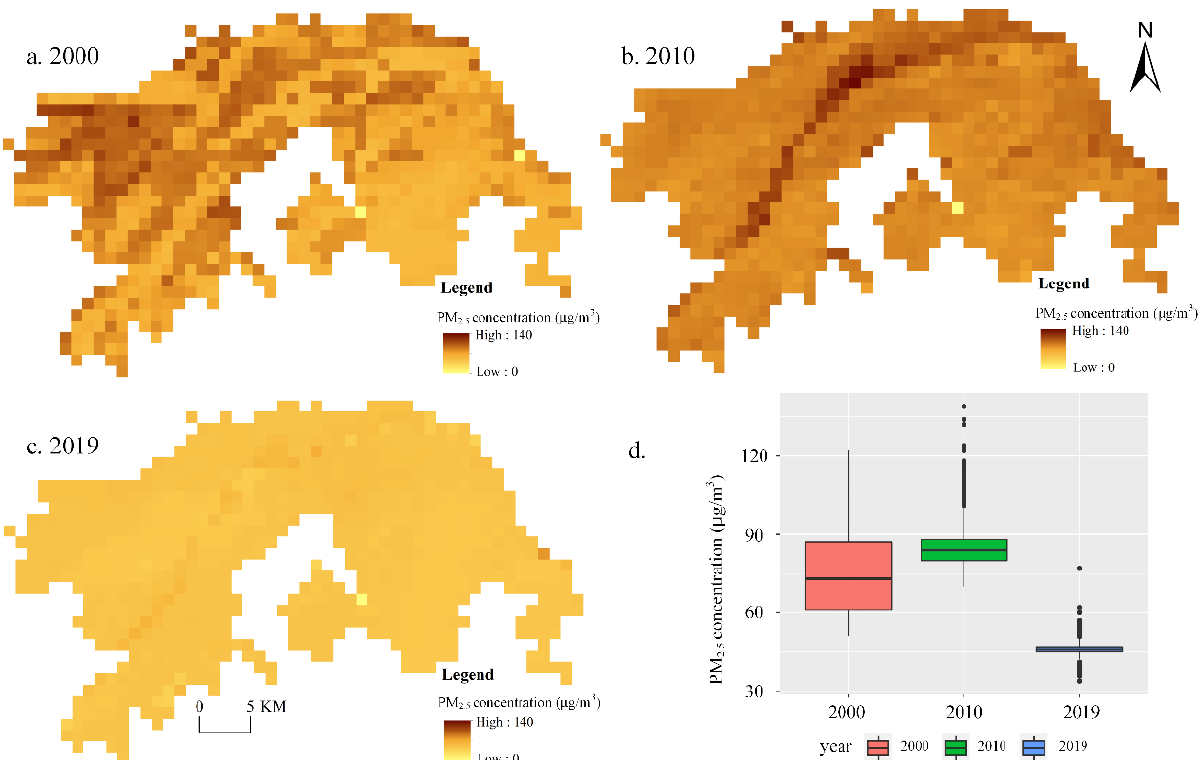
Figure 3. Spatial and temporal changes in annual PM 2.5 concentrations in the central city of Wuhan from 2000 to 2019 ( a – c ): PM 2.5 concentration maps were extracted from the annual PM 2.5 concentration maps of China [56]; ( d ): boxplot of PM 2.5 concentration. The interquartile range is from the 25th percentile to the 75th percentile. The 50th percentile is the median, represented by the middle black line).